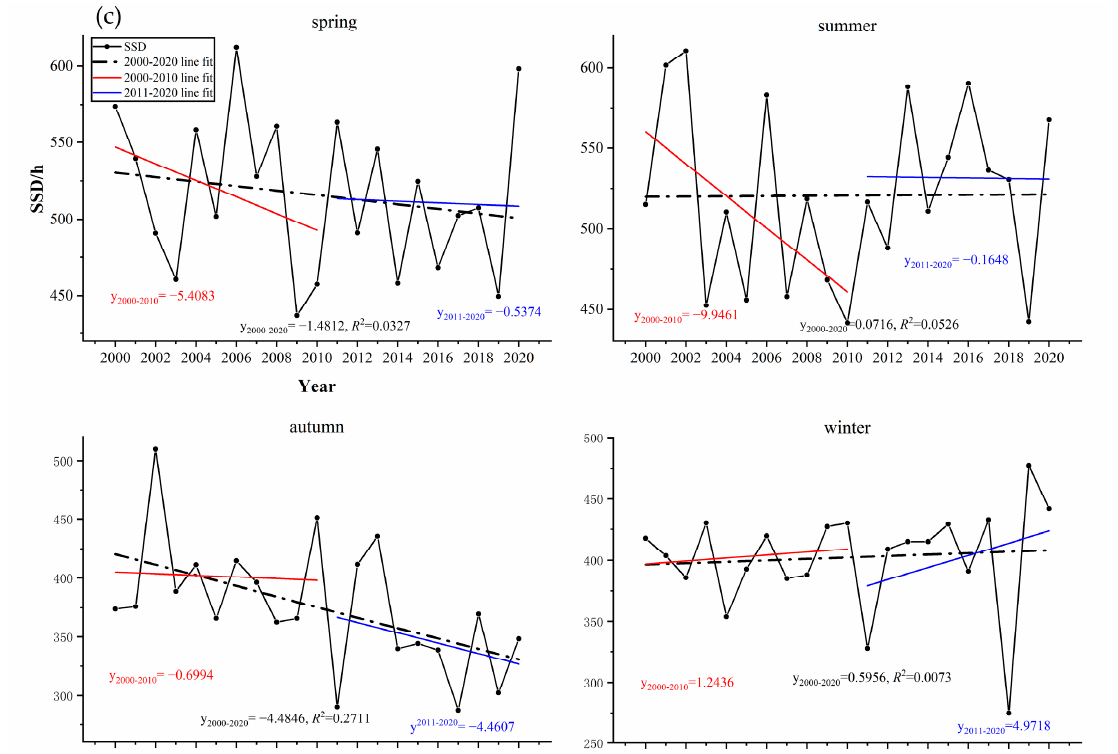
Figure 7. Seasonal mean changes of climate factors in the QBM from 2000–2020: ( a ) TEM ; ( b ) PRE ; ( c ) SSD.